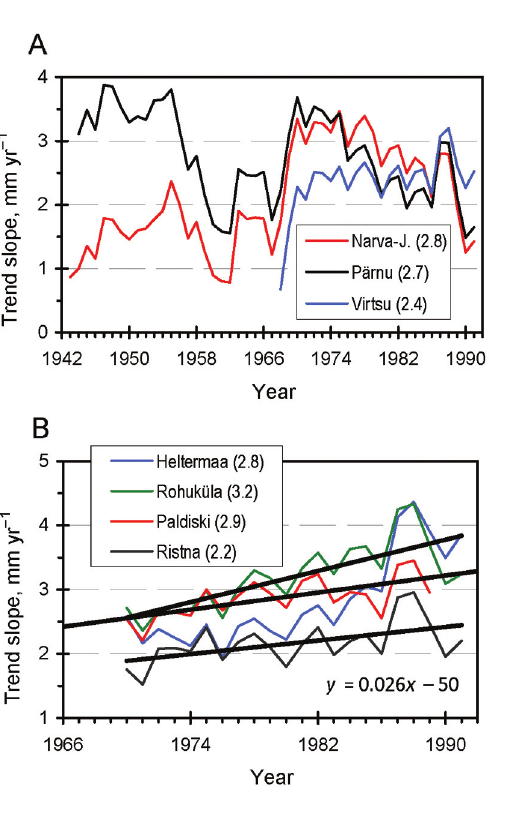
Fig. 7. Time series of slopes of trend lines corrected with land uplift rates for 41-year periods, where the value is assigned to the middle year of the running window; for example, 1970 for 19501990 and 1991 for 19712011. The numbers in parentheses mark average slope values in mm yr 1 for the period covered by the graphs, e.g. 19431991 for Narva- Jõesuu ( A ), representing 19232011 and 19701991 in ( B ), representing 19502011. The increasing trend in sea level trend slopes describes sea level acceleration, as shown, e.g., for Ristna in ( B ); roughly similar accelerations could be calculated by fitting quadratic to the sea level time